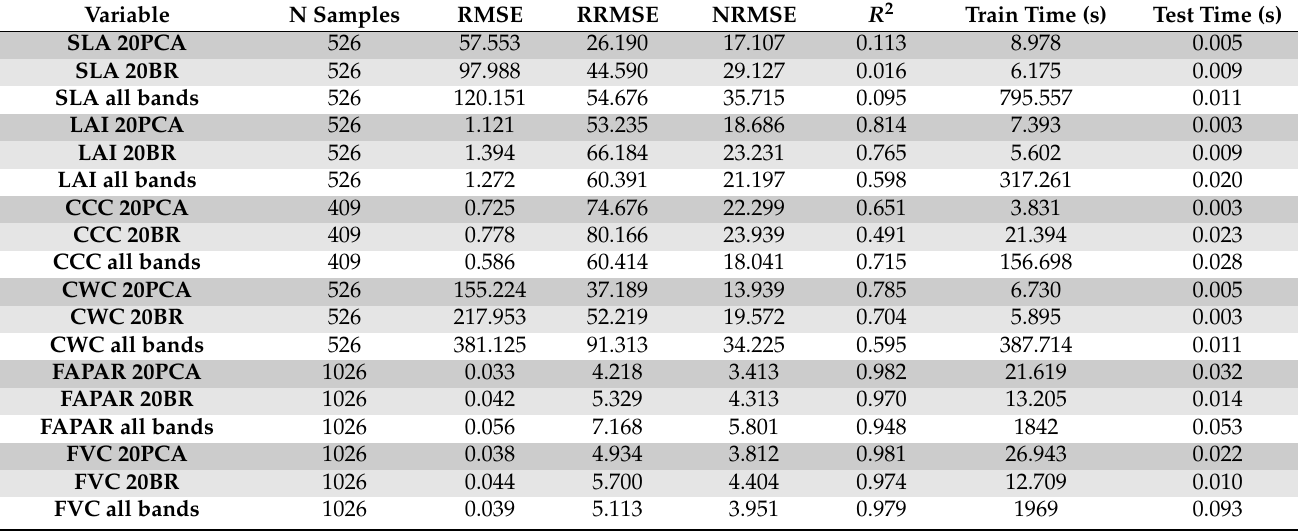
Table 5. Goodness-of-fit statistics against the Grosseto and MNI in situ datasets (and theoretical results for FVC and FAPAR) were achieved with both methodologies, GPR-20PCA and GPR-20BR, and also with all available bands: variables, number of samples (N), RMSE, relative RMSE (RRMSE), NRMSE, R 2 , as well as computational time (s: seconds) for algorithm training and model